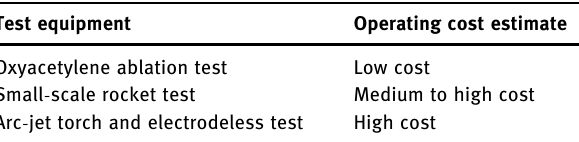
Table 1: Operating cost estimate for some ablation tests [ 3,7 ]